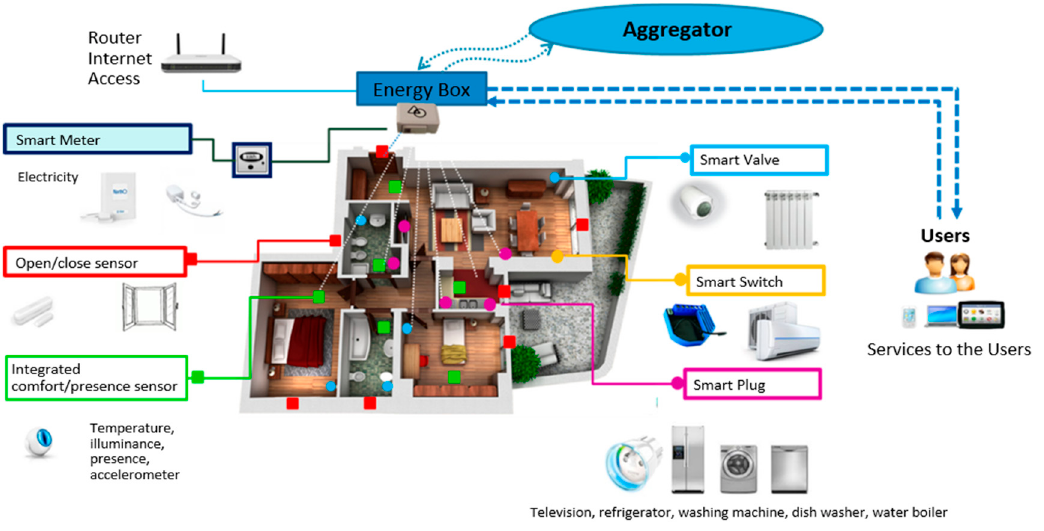
Figure 5. Control kit layout. Table 4. Control kits configuration for the